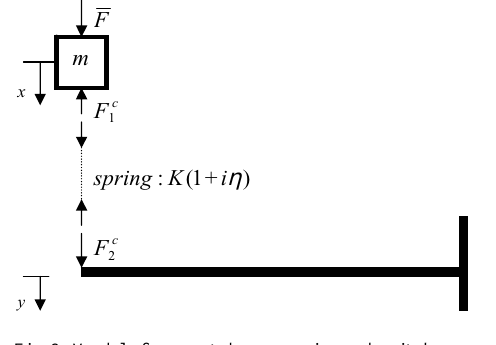
Fig. 3. Model of connected mass, spring and finite